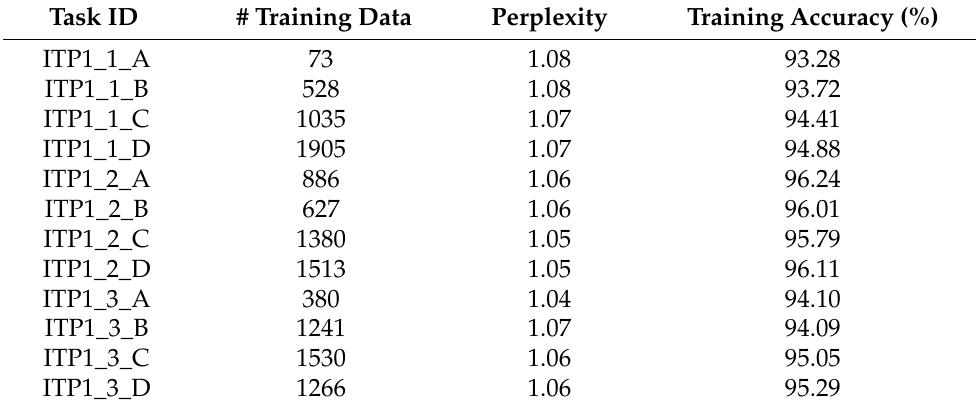
Table 3. Training accuracy of